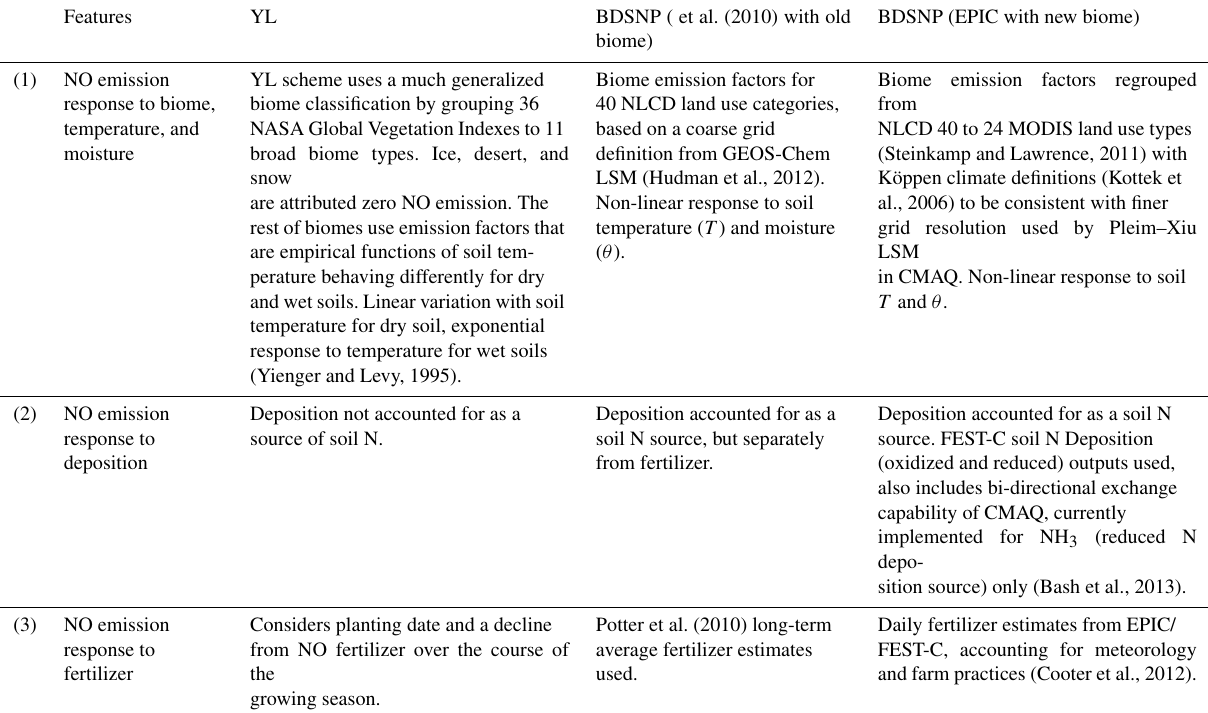
Table A3. Summary of differences between YL, and the two applications of BDSNP. See Table 1 for other aspects of model configuration.